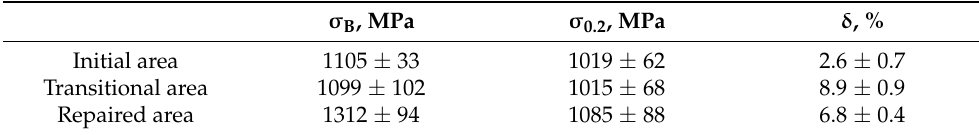
Table 4. Mechanical properties of additively formed product sample (each value is an average of three results presented in Appendix A).